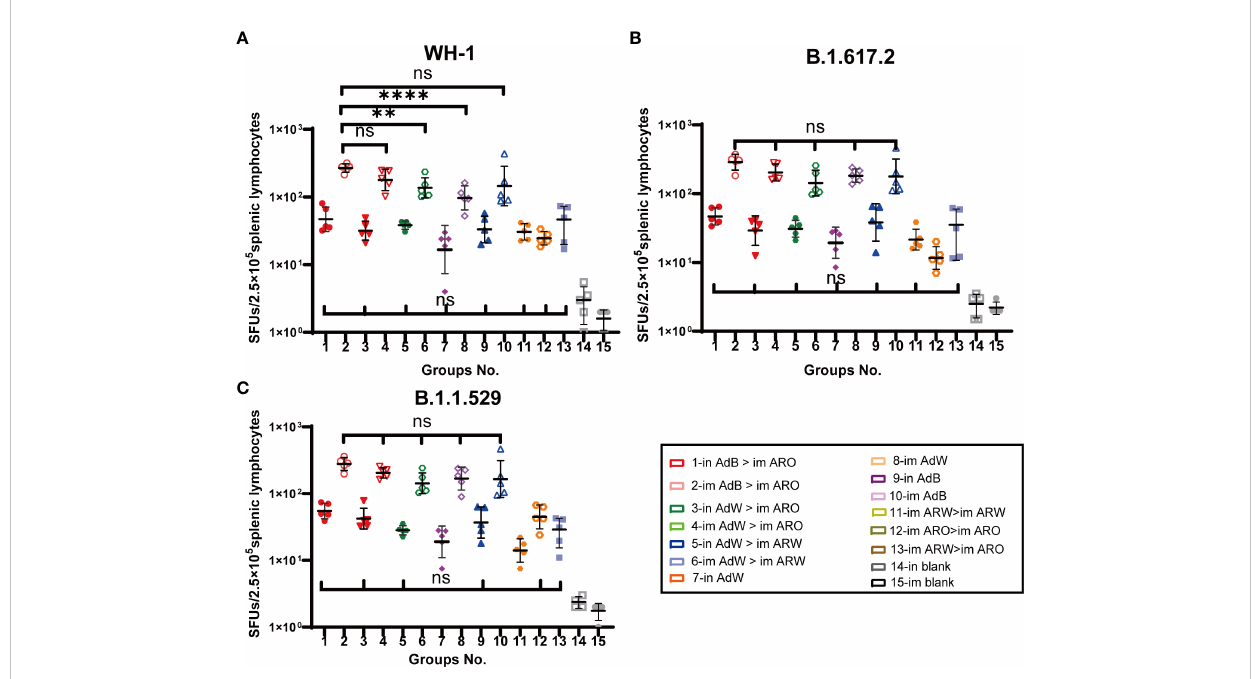
FIGURE 8 Cellular immune responses speci fi c to SARS-CoV-2 spike proteins were measured 49 days after primary vaccination. Enzyme-linked immunospot (ELISpot) assays for IFN- g after stimulation with the SARS-CoV-2 spike protein. Five mice per group were euthanised, and T-cell responses were measured. Lymphocytes were stimulated with (A) WH-1, (B) B.1.617.2, and (C) B.1.1.529 spike peptide pools spanning the entire spike protein sequence. Cells secreting IFN- g were quanti fi ed using ELISpot assays (n = 5 per group; each point represents the mean number of spots from two wells per sample). Bars represent the geometric mean ± geometric SD; **P < 0.01; ****P < 0.0001; ns, P >